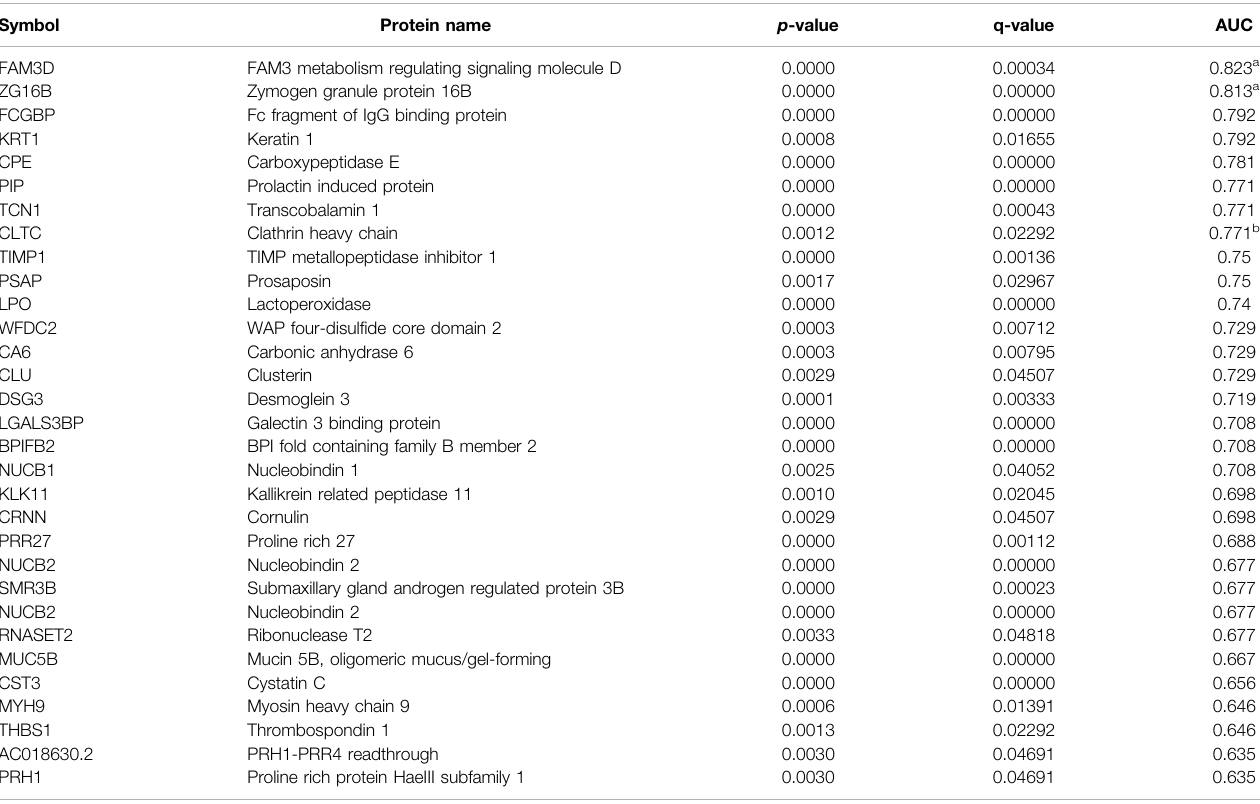
TABLE 3 | Differentially down-regulated proteins in